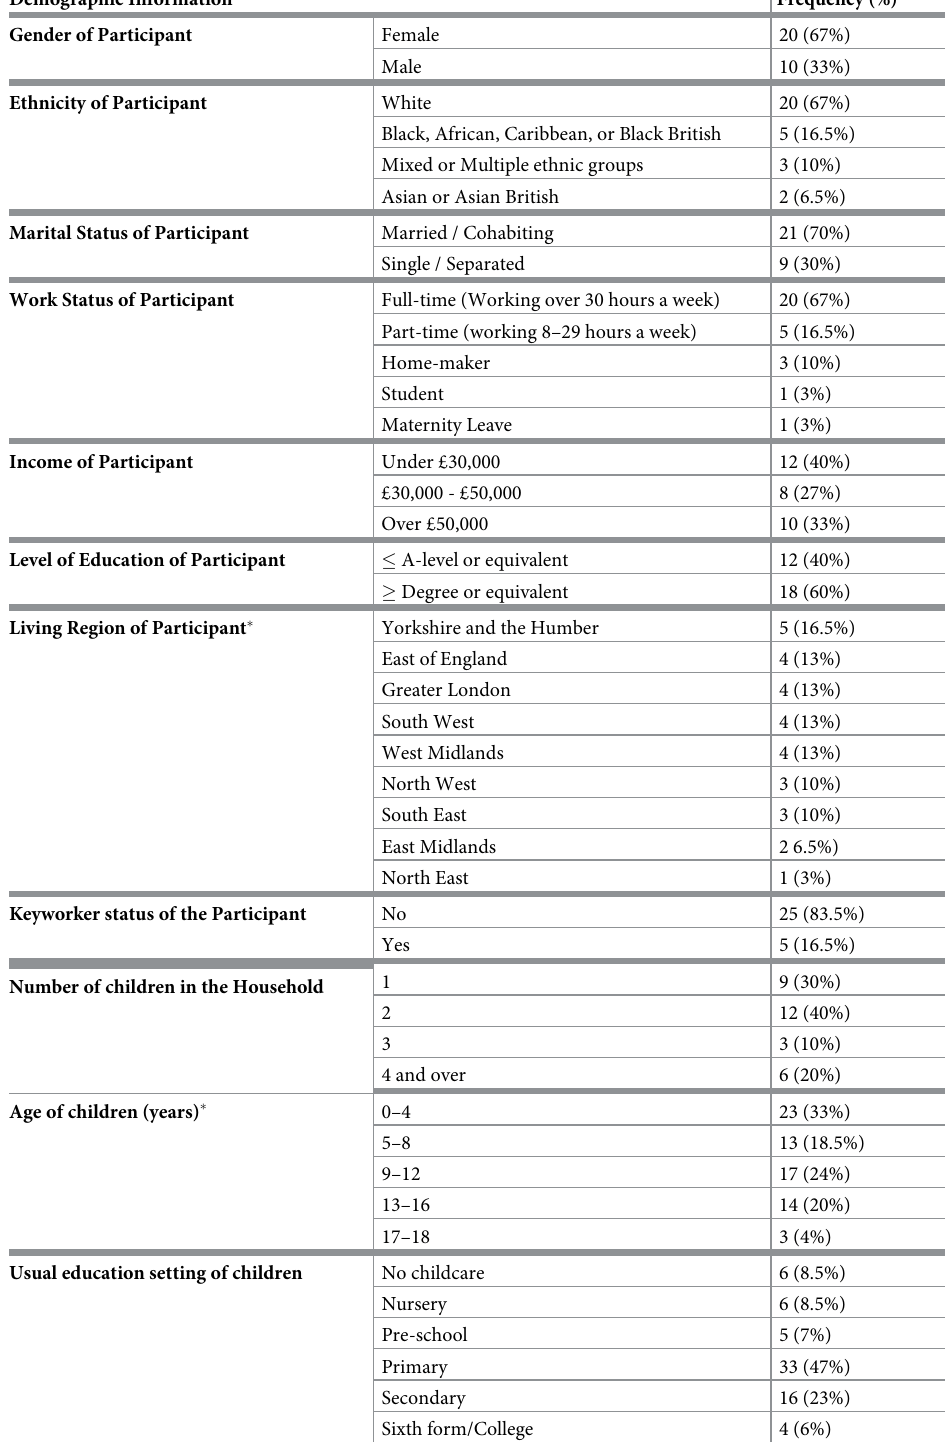
� Percentages do not total 100 due to rounding